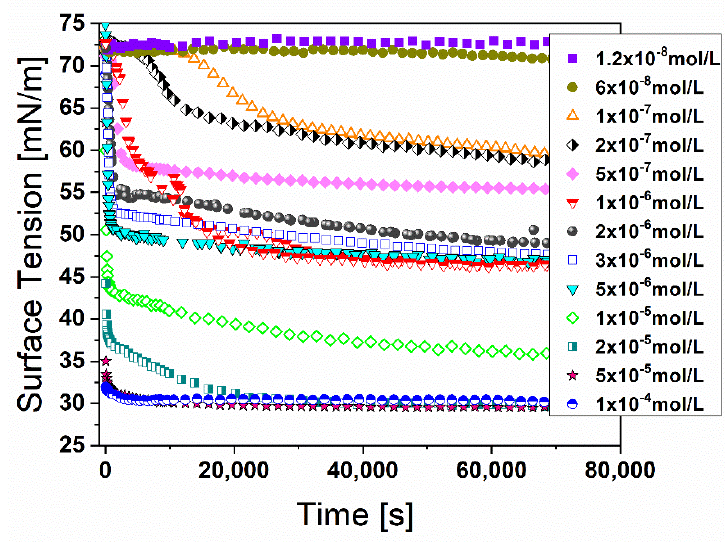
Figure 1. Dynamic surface tension curves of aqueous solutions of mixture C 12 E 5 / CTAC 1:1 for various total concentrations; 0.1 mol/L NaCl is added to all solutions and the temperature is 20 °C.